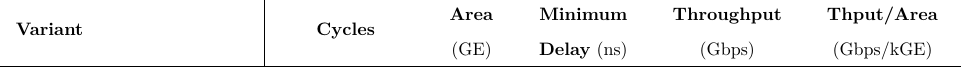
Table 3: ASIC Implementations of Remus and Romulus using the TSMC 65nm standard cell